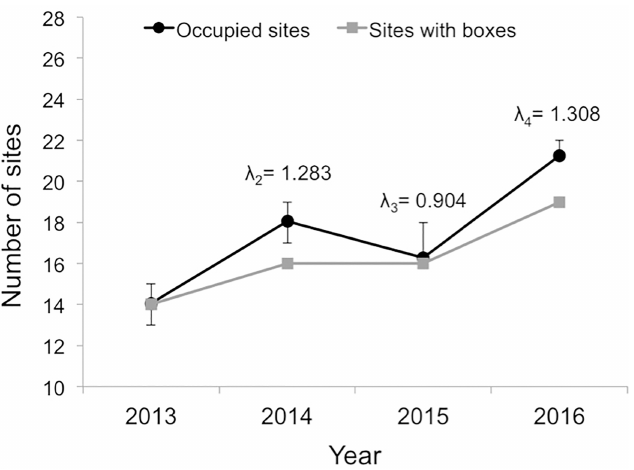
Fig 2. Number of sites with nest boxes and mean estimatesof number of sites occupied by kestrels between 2013–2016. Error bars indicate 95% credibleintervals. Occupancy-basedpopulationgrowth rates λ 2–4 refer to changes since